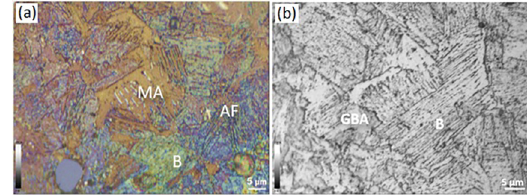
Figure 3. 0.08 Nb steel: the first shows the microstructure after quenched at 900 ºC (Lepera - COM). The second shows the microstructure after quenched at 900 ºC and tempered at 600 ºC (Nital 2% - COM). Figures 4a and 4b present the microstructures of